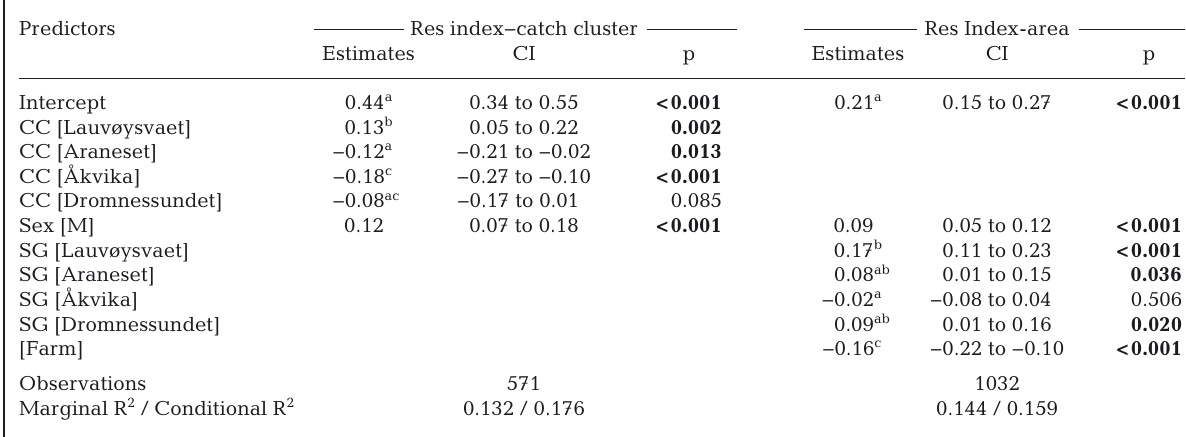
Table 3. Results of the cod residence index (Res Index) analyses using catch cluster (CC) or spawning grounds (SG) as the grouping variable. Square brackets indicate a categorical variable. The treatment contrast of R was used with the intercept representing the value for females at Glasøysvaet with values for the other CC/SG showing how they compare to this refer- ence value. Letters show the results of Tukey’s post hoc tests, with different letters indicating significant differences (p < 0.05).